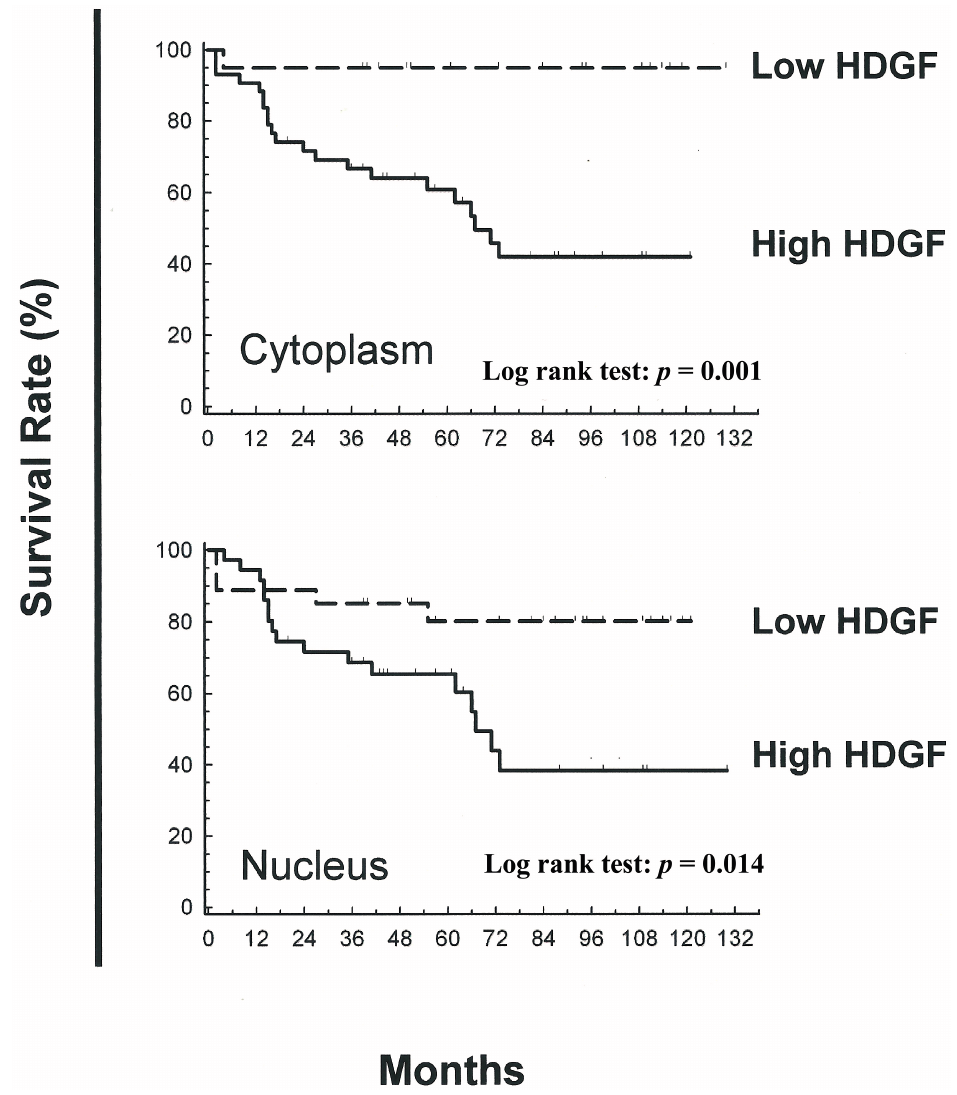
Figure 2. Kaplan-Meier analysis of overall survival rates for patients with cervical adenocarcinoma (Cx) exhibiting different subcellular HDGF expression levels. Correlation between cytoplasmic HDGF and overall survival. Patients with a lower expression of cytoplasmic HDGF had significantly more favorable survival rates compared with the patients with higher expression of cytoplasmic HDGF ( p = 0.001). The correlation between nuclear HDGF and overall survival: patients with a lower expression of nuclear HDGF had better overall survival results than the patients with a higher expression of HDGF ( p =